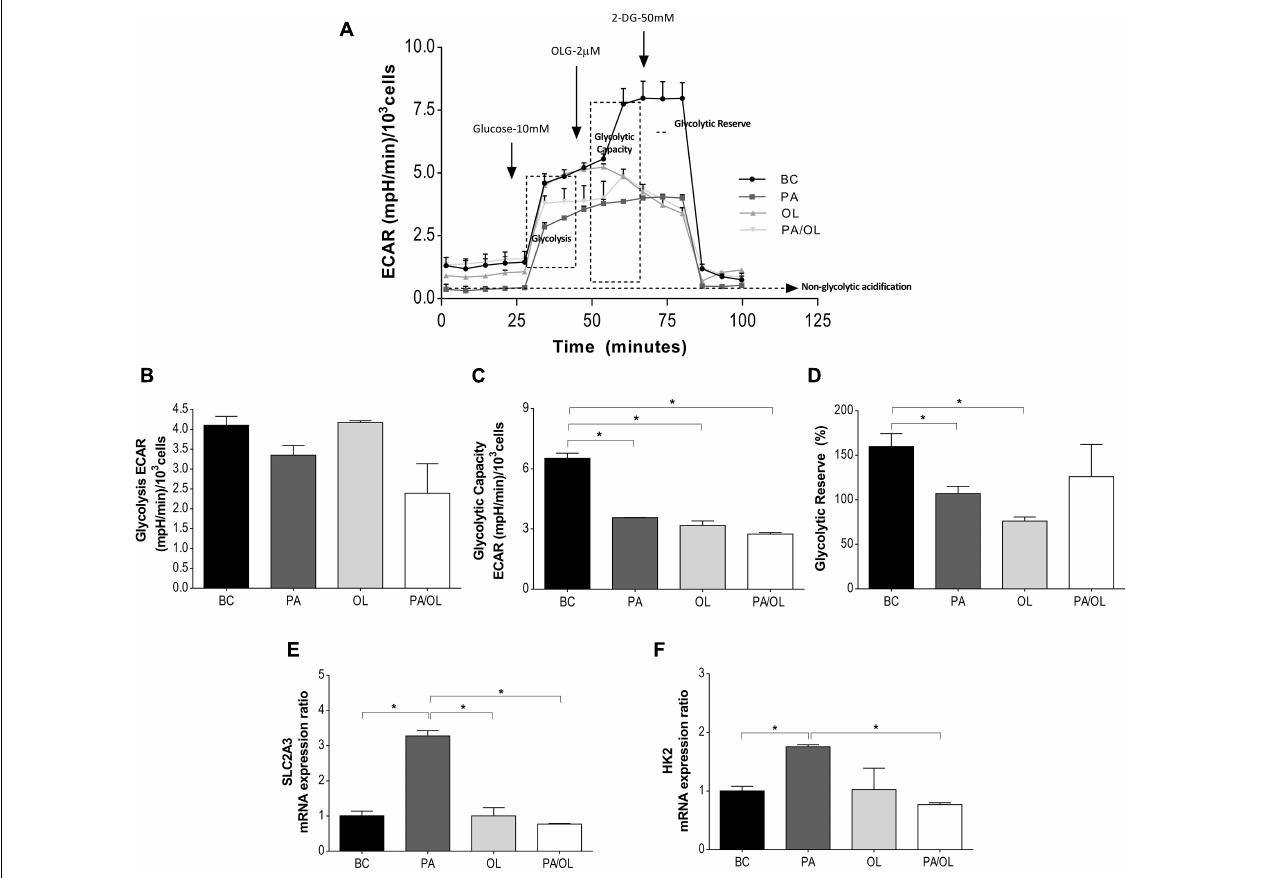
FIGURE 3 | Analysis of glycolytic function by measurement of the rate of extracellular acidification (ECAR). (A) Representation of the ECAR versus time for each of the fatty acid (FA) test solution (without FBS)incubations following the addition of glucose at 10 mM, OLG at 2 µ M, and 2-DG at 50 µ M. From these ECAR values, the following parameters were calculated: (B) ECAR due to glycolysis; (C) the glycolysis capacity; and (D) the glycolytic reserve (%). Gene expression ratios of (E) SLC2A3 and (F) HK2 after FA incubations are also represented in relation to the BC. All data were obtained from three independent experiments, expressed as mean value ± deviation standard; * p < 0.05. BC = basal condition; PA = palmitic acid; OL = oleic acid; OLG = oligomycin; 2-DG = 2 deoxyglucose; FBS = fetal bovine